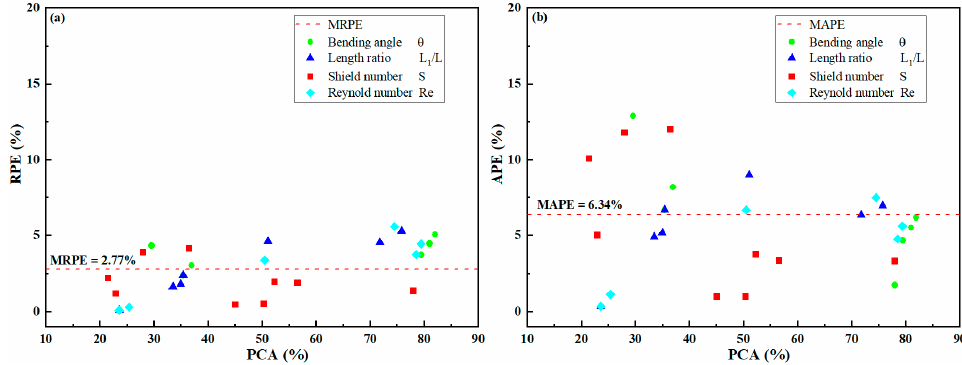
Figure 18. Error analysis. ( a ) Relative error; ( b ) Absolute error.